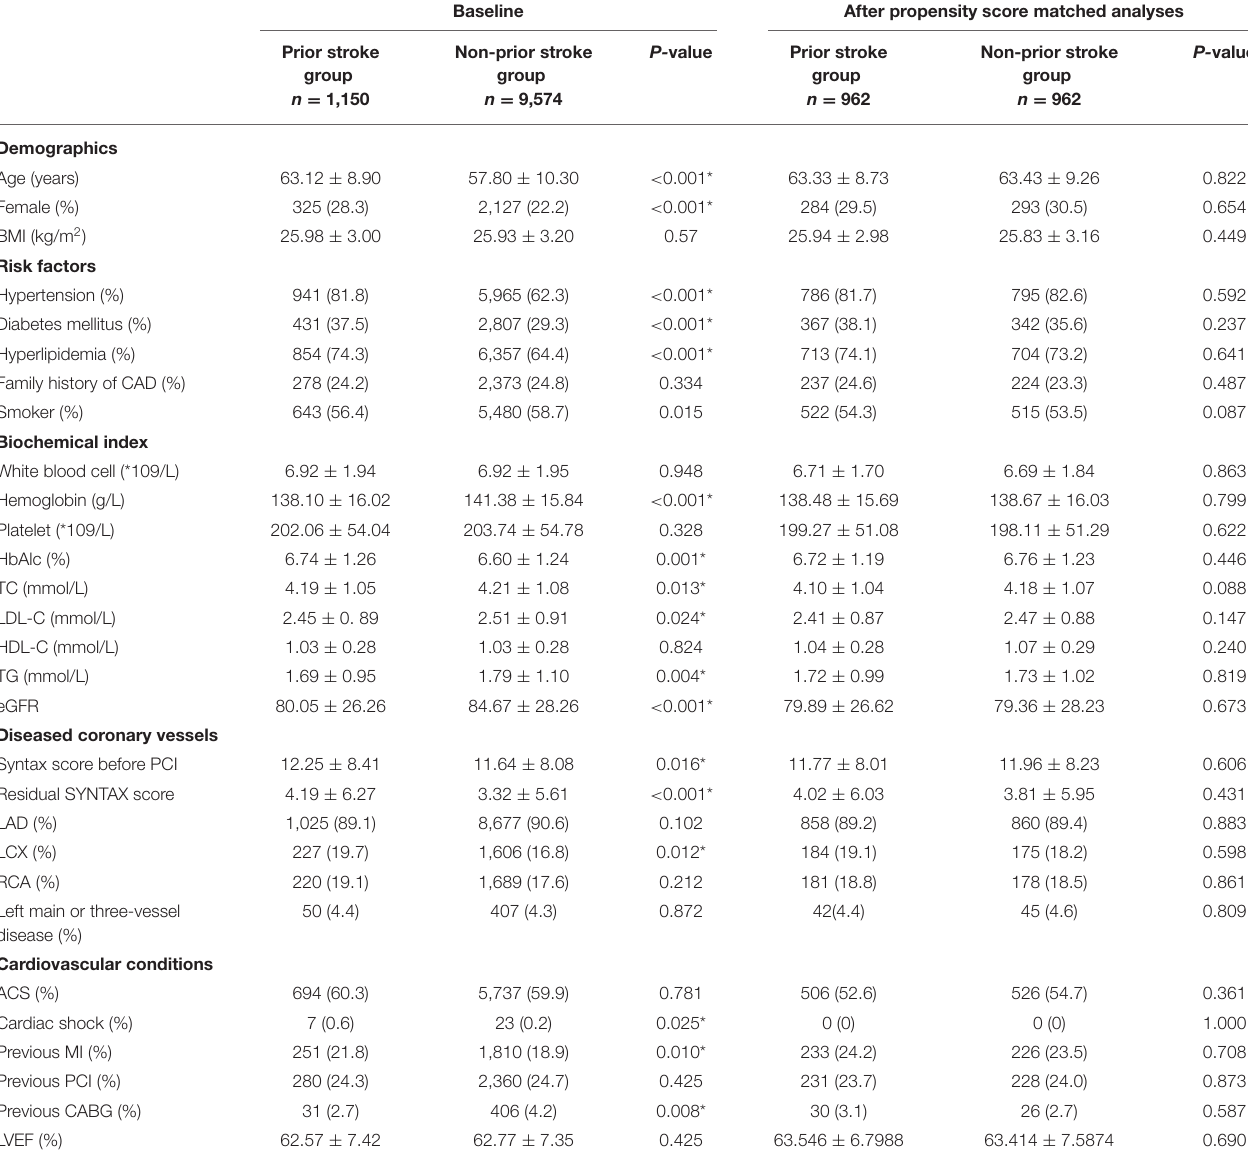
TABLE 1 | Baseline and propensity score matched data of two groups. Baseline After propensity score matched